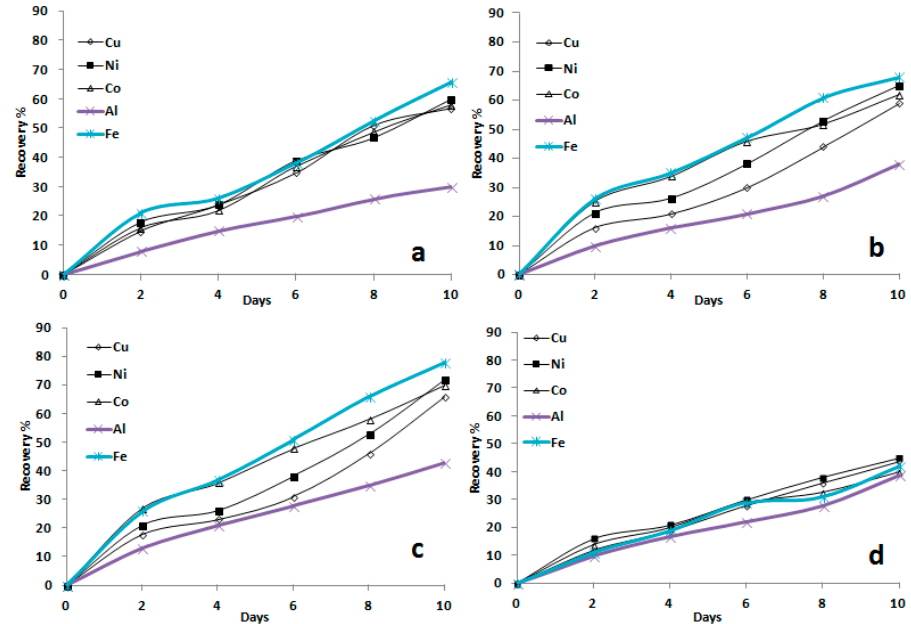
Figure 10. Metal recovery yields at various temperatures during fungal leaching of PCB, pH 2.0 at 8% pulp density [( a )-298 K, ( b )-303 K, ( c )-308 K, ( d )-313 K].